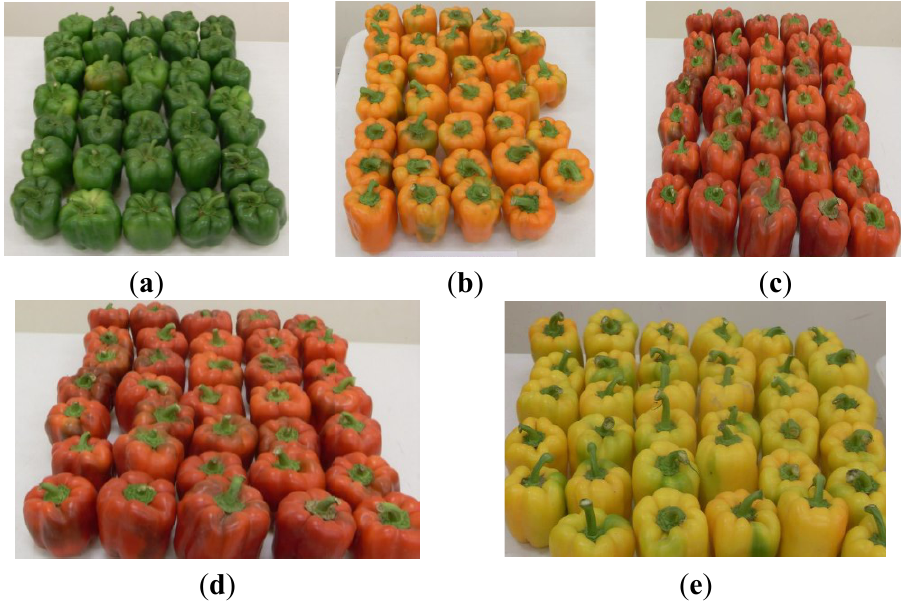
Figure 6. Samples of bell peppers harvested on 3 July 2013 used in the analysis: ( a) Sweet/Robusto; ( b ) Orangela/Terrano; ( c ) Fascinato/Robusto; ( d ) Fascinato/Terrano; and ( e ) Jeanette/Terrano.